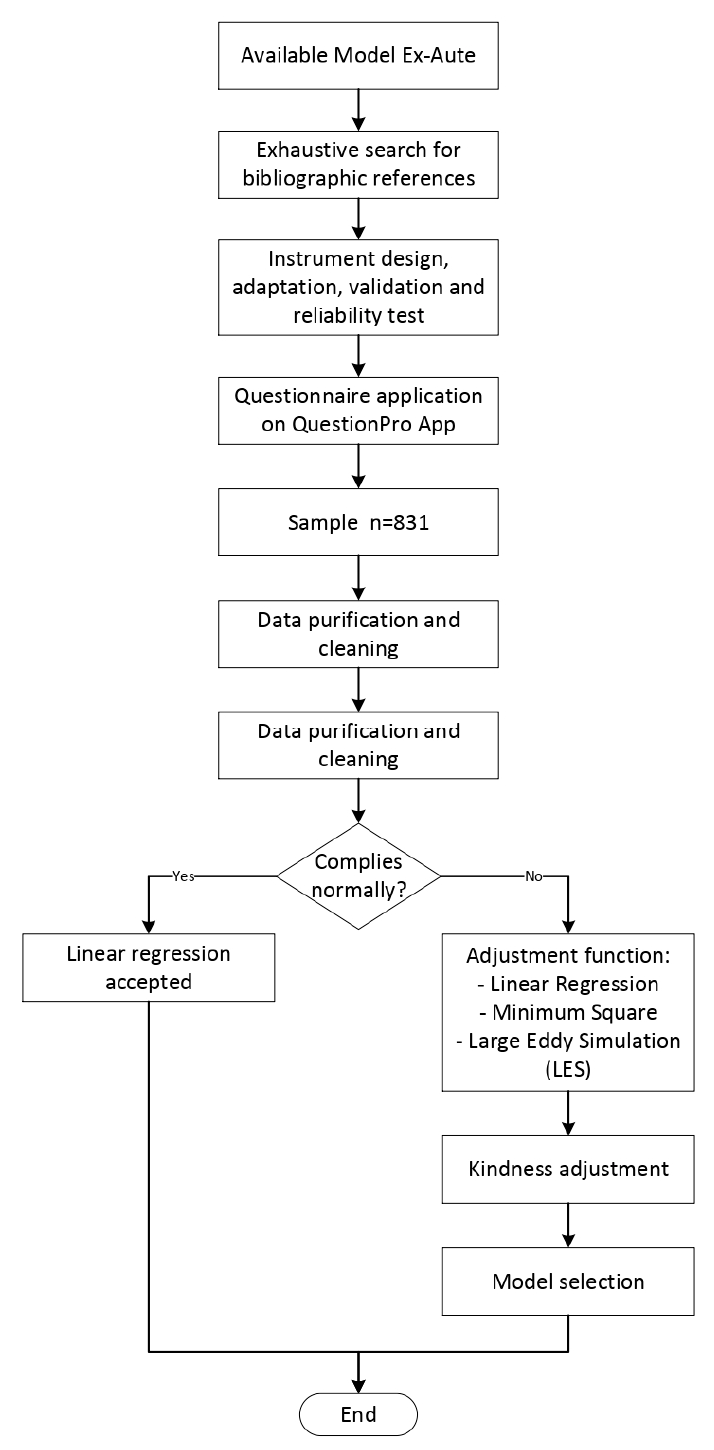
Figure 1. Work Flow. Source: Own elaboration. As indicated in Figure 1, after exhaustive search and questionnaire adaptation and design, we used the SBI questionnaire to measure burnout designed by Gil-Monte and the